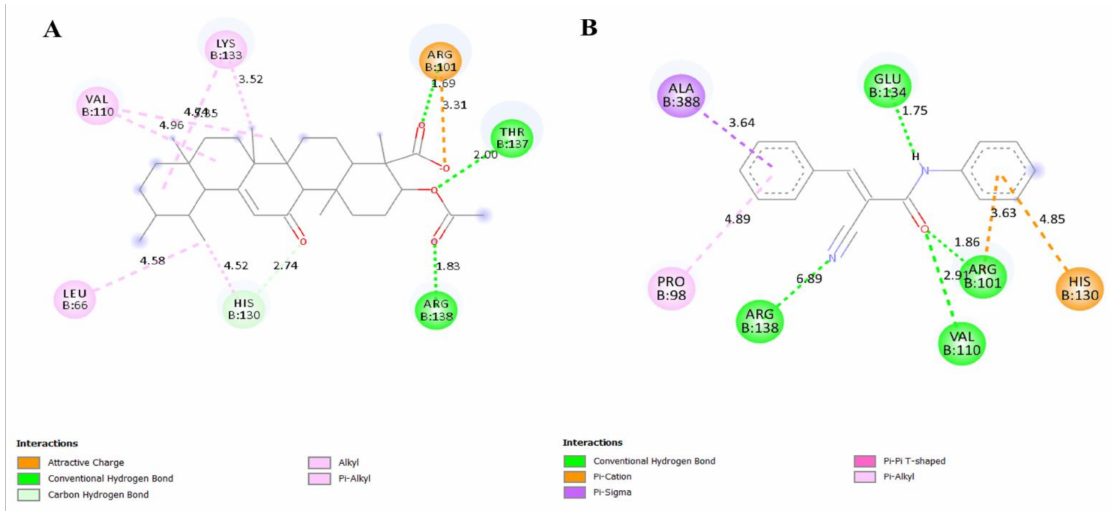
Figure 10. Ligand AKBA ( A ) and JMPR-01 ( B ) in 5-LOX target (PDB ID: 6NCF). JMPR-01 interacted with two highlighted residues (His 130 and Arg 101) and also shared interactions with Val 110 and Arg 138. Further, the complementary portion com- posed of Glu 134, Ala 388, and Pro 98 was indicated. Yet the compound under study presented greater affinity for the enzyme LTA4 hydrolase, with a free binding energy close to the co-crystallized ligand, Bestatin, which is a reversible inhibitor of this enzyme with IC 50 = 4.0 ± 0.8 µ M [63]. In Figure 11, an interactive overlap suggests influence on the catalytic domain of the target (Zn 2+ coordinated by His 295, His 299, and Glu 318) from interactions with His 295, and Zn2+ that are essential for LTB4 biosynthesis of [64]. Through in silico studies, carried out in molecular docking, it was possible to predict